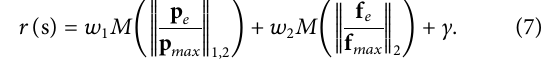
Frontiers in Robotics and AI |